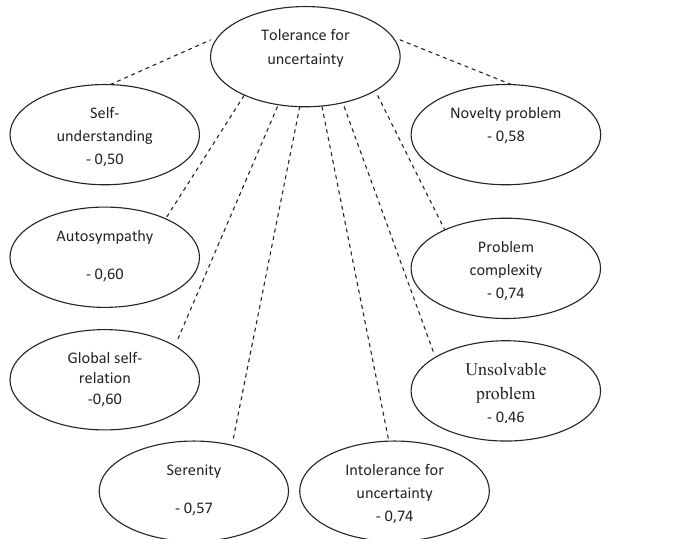
Fig. 2.2. The correlation parameter “Tolerance of uncertainty” of PCRS method with parameters of other methods (group surveyed students of the University of the Third Age). Source: Authors` research.